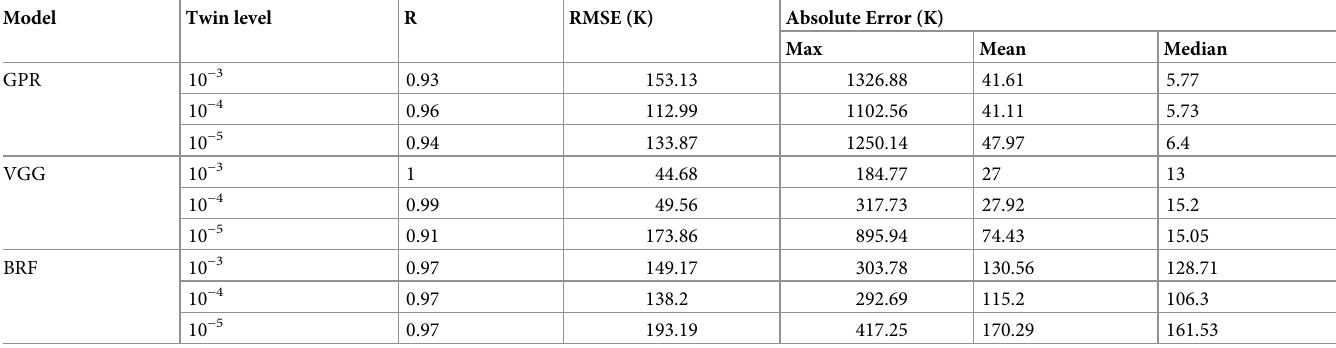
Table 8. Generalization performance of retrained models on uniform-profile spectra.